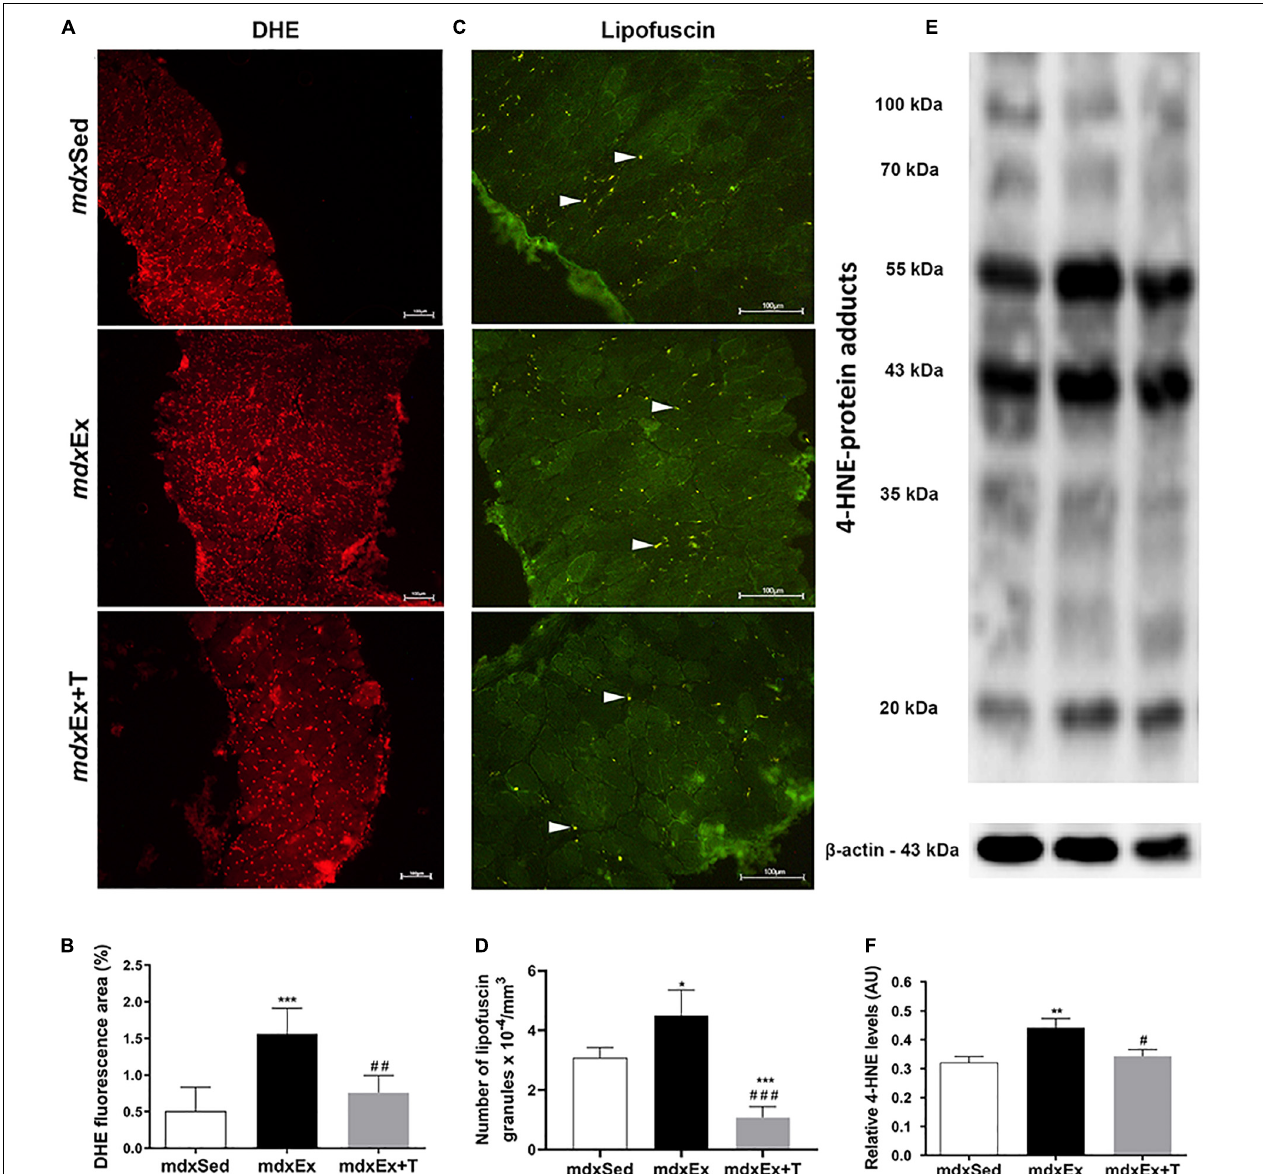
FIGURE 5 | Tempol effects on the oxidative stress markers. (A) Diaphragm (DIA) cross-sections showing dihydroethidium (DHE) fluorescence in sedentary mdx mice (mdx Sed), exercise trained mdx mice ( mdx Ex), and exercise trained mdx mice treated with Tempol ( mdx Ex+T). (B) The graphs show the DHE staining area (%) in DIA muscles of the mdx Sed, mdx Ex, and mdx Ex+T groups. (C) DIA cross-sections showing autofluorescent lipofuscin granules (white arrowheads) in DIA muscles of the mdx Sed, mdx Ex, and mdx Ex+T groups. (D) The graphs show the number of lipofuscin granules x 10 - 4 /mm 3 in DIA muscles of the mdx Sed, mdx Ex, and mdx Ex+T groups. (E) Western blotting analysis of 4-hydroxynonenal (4-HNE)-protein adducts. Bands corresponding to protein (top row) and β -actin (used as loading control) (bottom row) are shown. (F) The graphs show the protein levels in the crude extracts of DIA muscle from the mdx Sed, mdx Ex, and mdx Ex+T groups. All values expressed as mean ± standard deviation (SD). * P ≤ 0.05 compared with the mdx Sed group, ** P ≤ 0.001 compared with the mdx Sed group, *** P ≤ 0.0001 compared with the mdx Sed group, # P ≤ 0.05 compared with the mdx Ex group, ## P ≤ 0.001 compared with the mdx Ex group, ### P ≤ 0.0001 compared with the mdx Ex group (one-way ANOVA with Tukey’s post hoc